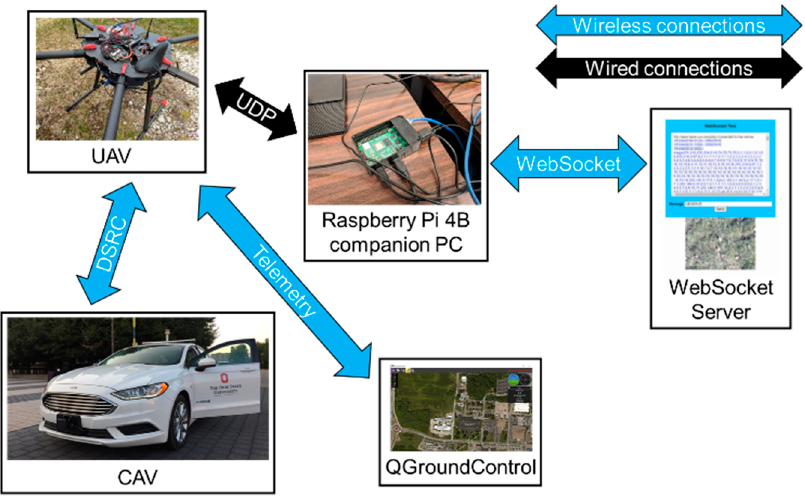
Figure 8. Schematic for experiment 1.